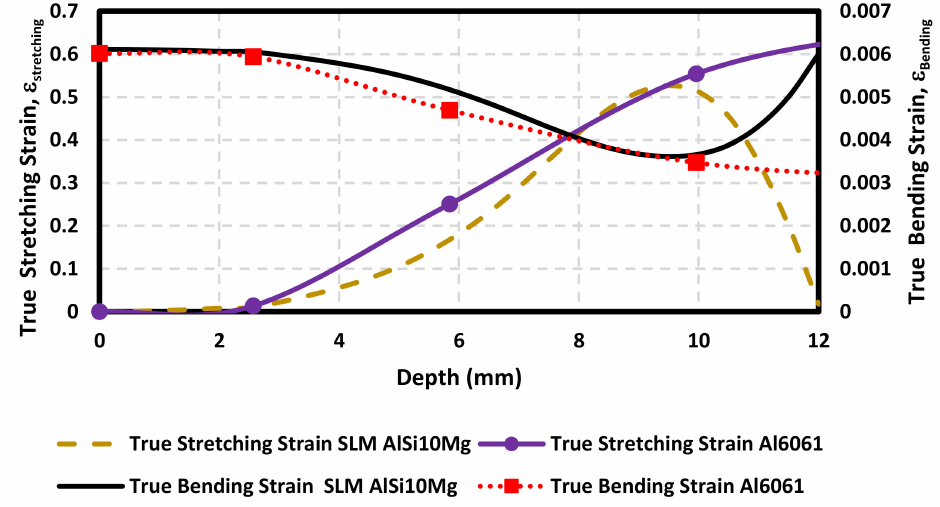
Figure 9. Calculated true stretching and bending strain curves for AlSi10Mg and